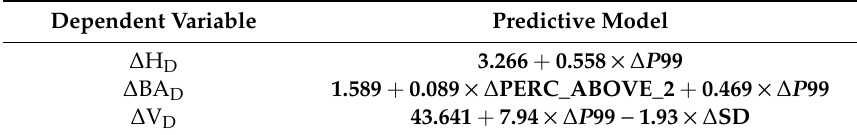
Figure 4. Scatterplots of the observed versus predicted values for change in top height (H), basal area (BA), and volume (V) using the indirect and direct approaches. Table 3. Predictive models for change in top height ( ∆ H D ), change in basal area ( ∆ BA D ), and change in total volume ( ∆ V D ) under the direct approach. Predictor variables used in these models included the change in 99th percentile of point heights ( ∆ P99), the change in proportion of points above 2 m ( ∆ PERC_ABOVE_2), and the change in standard deviation of point heights ( ∆